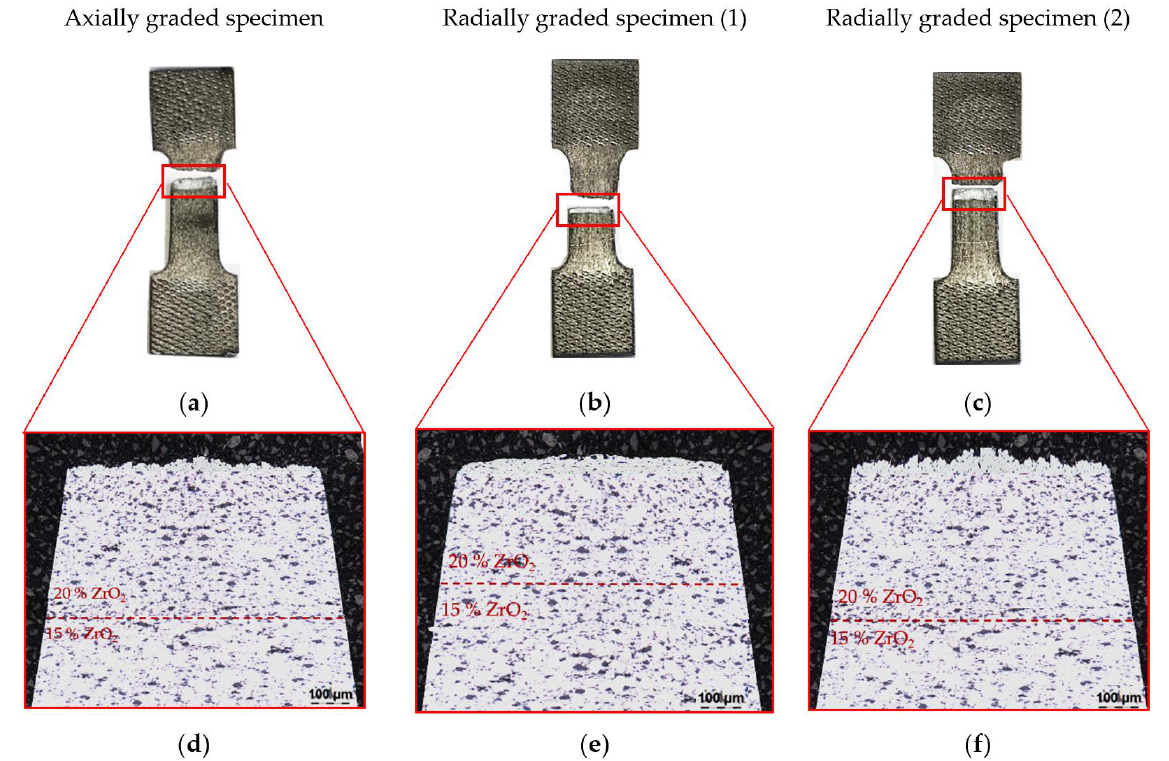
Figure 12. Tensile test specimens with ( a ) axially graded, ( b ) radially graded (1), ( c ) radially graded (2) particle distributions,